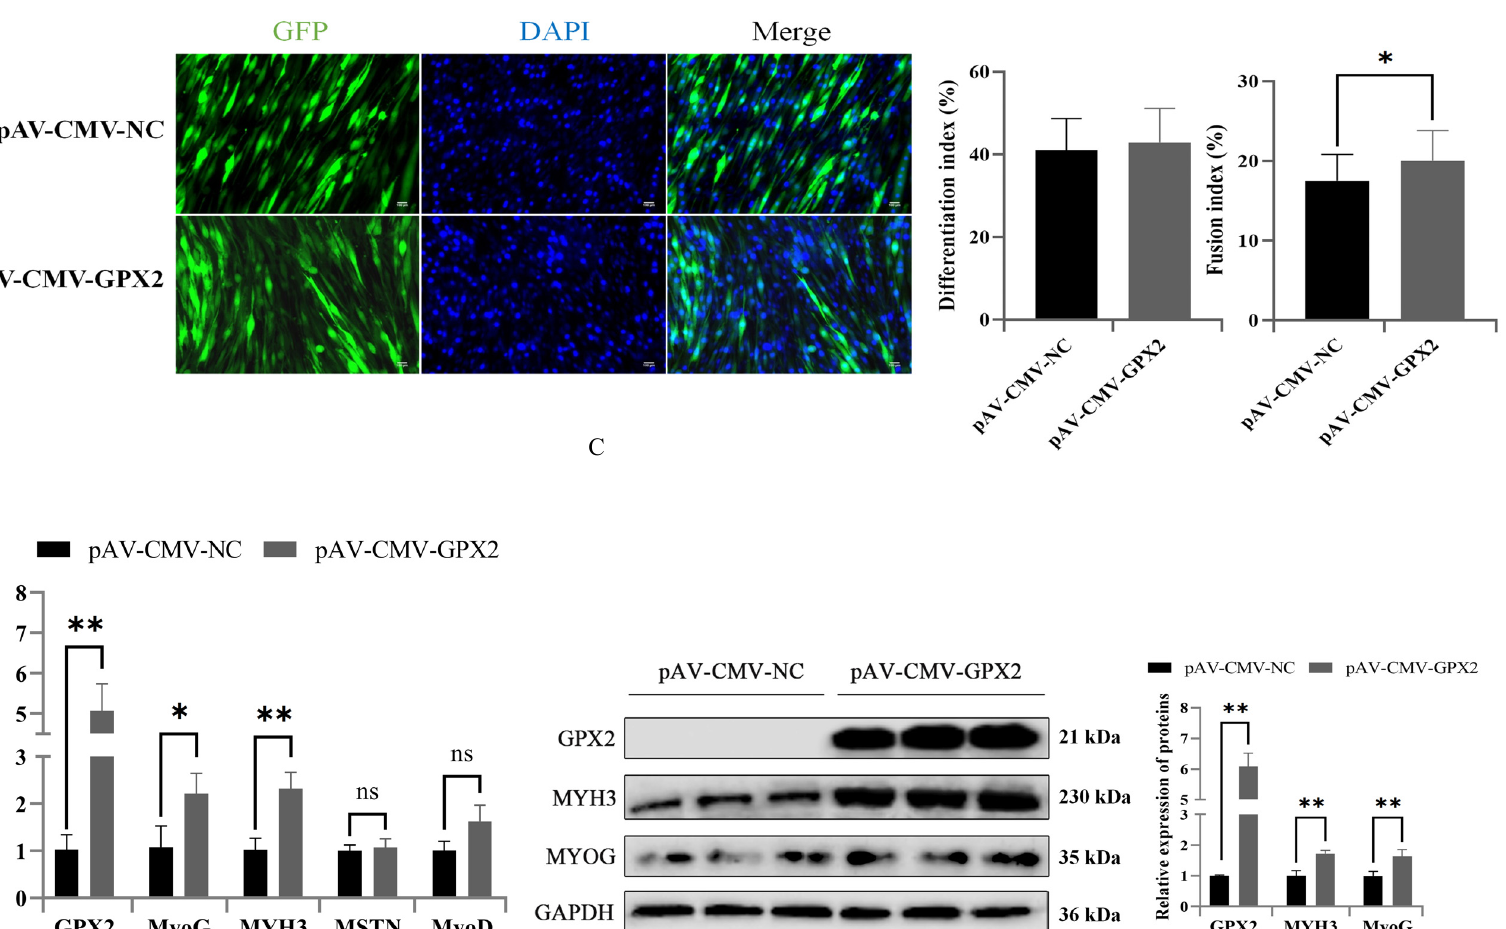
Figure 7. Overexpression of GPX2 promoted the C2C12 myogenic differentiation. ( A ) Representative immunostaining images comparing the cells in the myogenic differentiation stage from negative control and overexpression of GPX2. Blue represents nuclear staining; Green represents green fluorescent protein. The differentiation index was calculated as the percentage of the number of nuclei in the myotube to the total nucleus. The fusion index was calculated as the percentage of the number of myotubes with more than two nuclei in the total nucleus. ( B ) The mRNA and protein expression. ( C ) level of GPX2 and myogenic marker protein were analyzed at 7-day differentiation after overexpression of GPX2 in the C2C12 cell. * indicates p < 0.05, ** indicates p < 0.01, ns indicates not